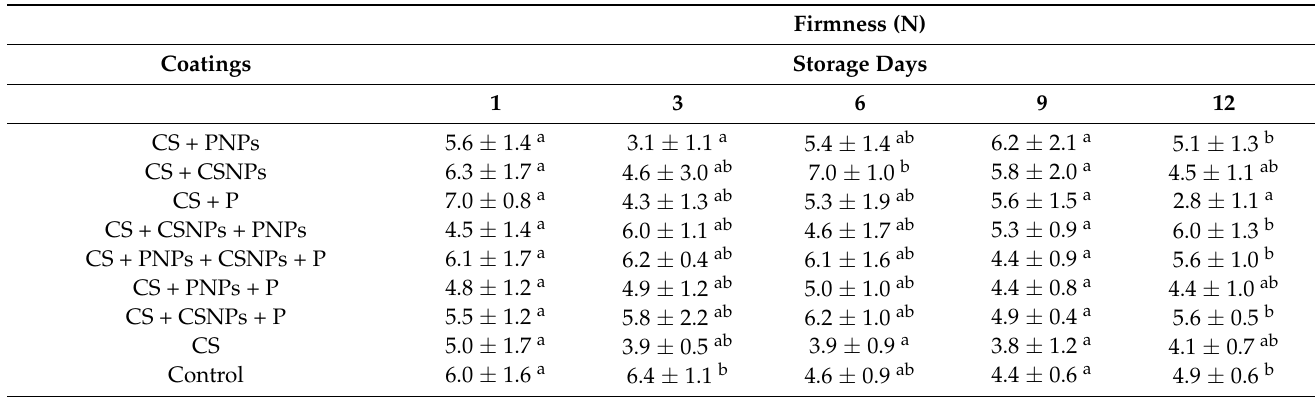
Table 1. Effect of edible chitosan/propolis coatings on the firmness of fig fruit stored for 12 days at 4 ◦ C.